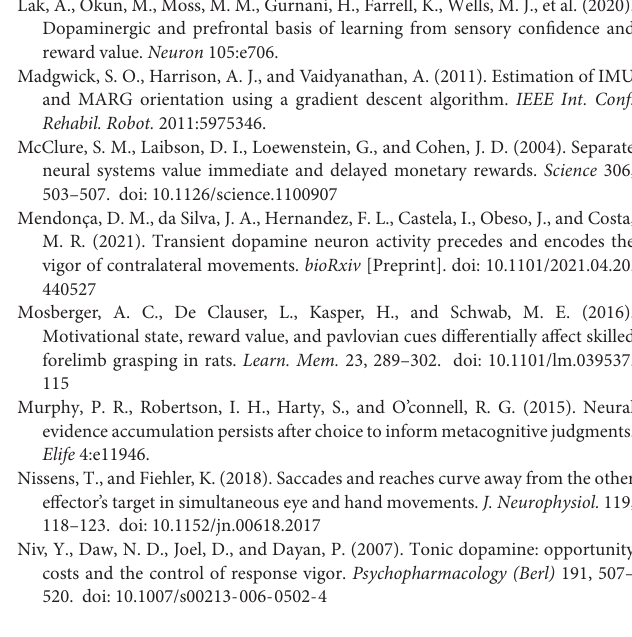
Supplementary Figure 1 | (A) Cue selection time vs. Chosen Value in DC trials for correct (dark red curves) and error (light red curves) trials during the main data set sessions with subject M1. (B) Same format as in (A) for subject M2. (C) Same format as in (A) for movement duration for subject M1. (D) Same format as in (C) for subject M2. (E) Same format as in (A) during the hand tracking sessions with subject M1. (F) Same format as in C during the hand tracking sessions with subject M1. The trials highlighted with shaded area in A were used to compute the effect of the chosen cue value on cue selection time and movement